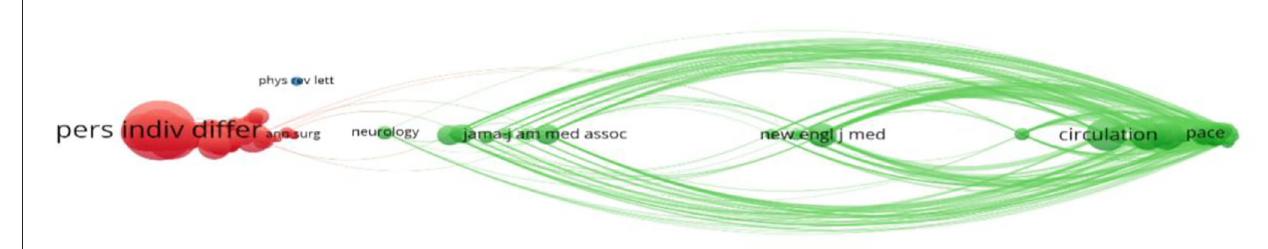
FIGURE 5 | The time zone view of the co-citation journal network: 1938–2021.